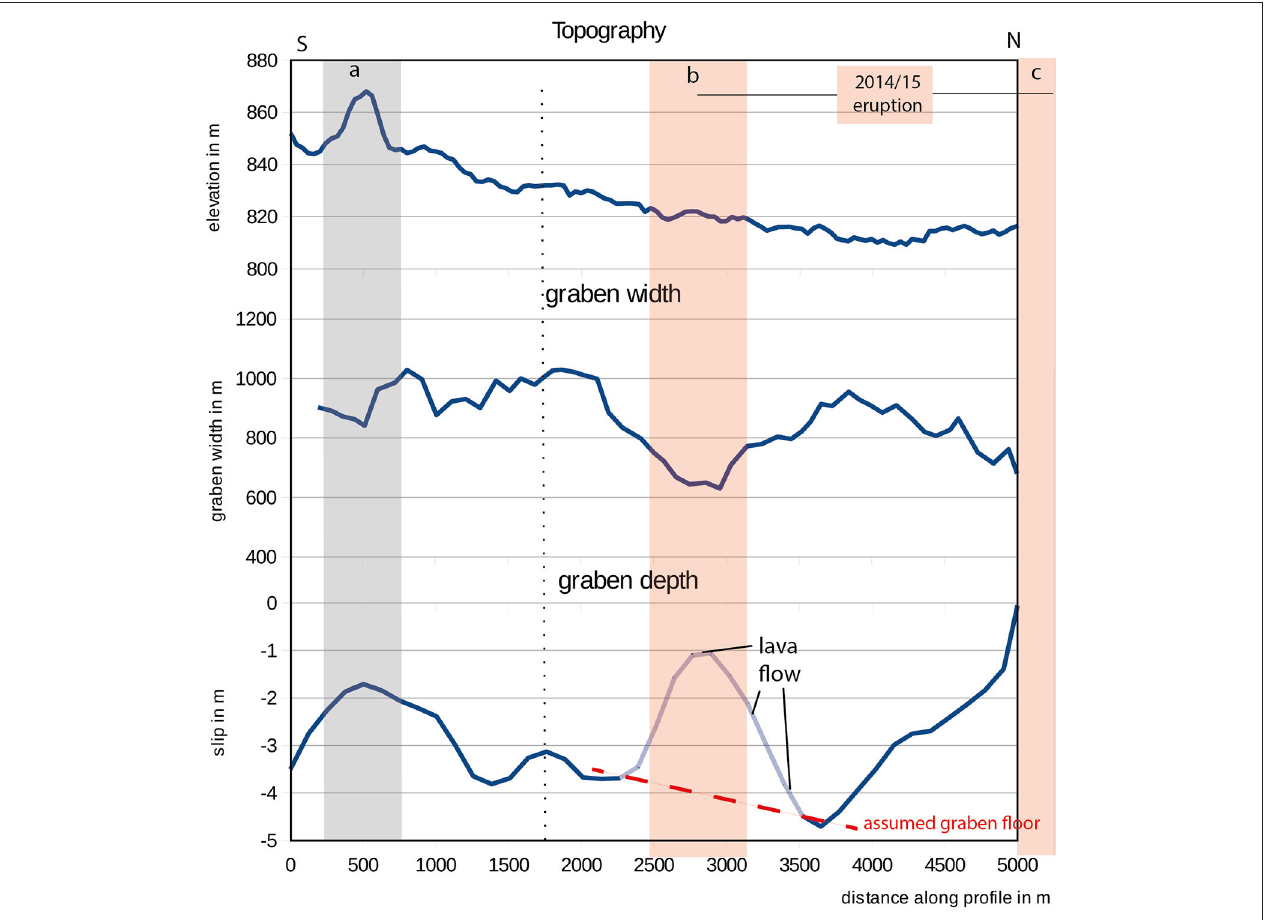
FIGURE 8 | Comparison of topography and relevant graben parameters. The elevation profile was drawn in the center of the graben from south (edge of the glacier) to north (Holuhraun eruption site). Graben depth and width were measured along parallel profiles (at a distance of 100m from each other), normal to the graben. Area a depicts the location of the 1862 crater, b depicts the location of the 5th September 2014 eruption site and c depicts the location of the Holuhraun main eruption site. The influence of the upward migrating dike segment at location b is clearly